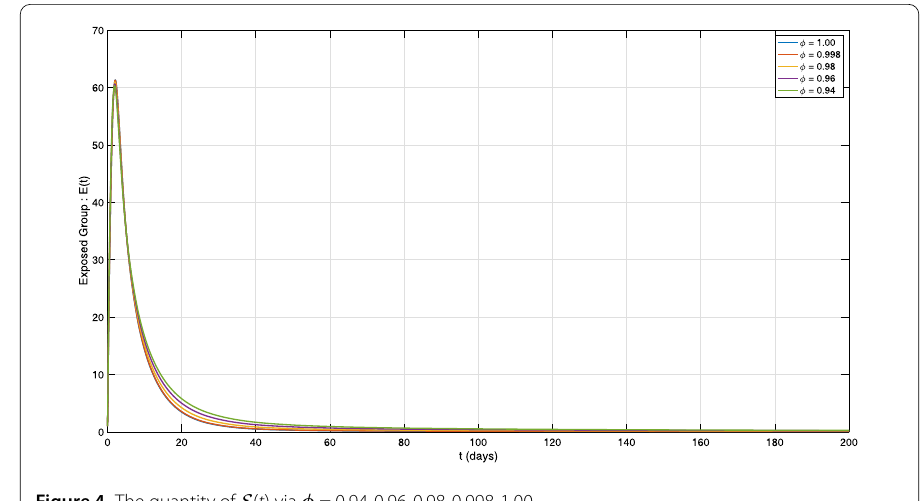
Figure 4 The quantity of E ( t ) via φ = 0.94,0.96,0.98,0.998,1.00